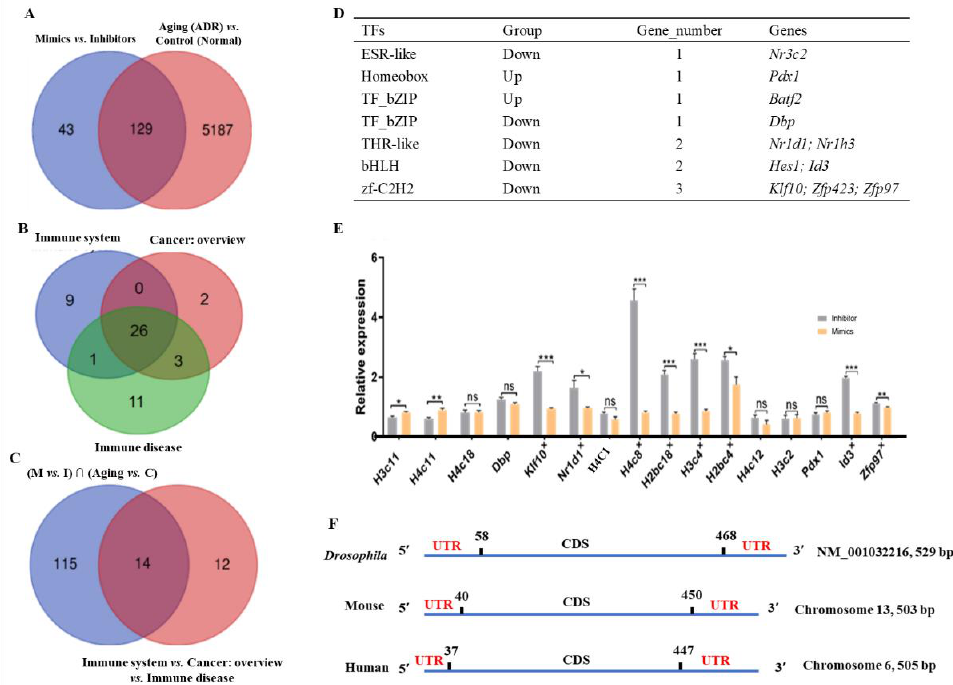
Figure 7. Target screening of tRF-Trp-CCA-014 in mouse NIH3T3 cells. ( A ) the overlapping DEGs between Mimics vs. Inhibitors groups and Aging (adriamycin ageing (adriamycin (ADR)) vs. Control (Normal) groups; ( B ) the overlapping DEGs in the immune system, cancer: overview, and immune disease; ( C ) the overlapping DEGs in ( A , B ); ( D ) the differentially expressed transcription factors between the Mimics vs. Inhibitors groups, including two upregulated genes and nine downregulated genes in the Inhibitors group when compared with the Mimics group; ( E ) the relative expression level of DEGs by qPCR; ( F ) sequence alignment of the H3C4 gene in mouse, human, and Drosophila . In ( C ): M—mimics; I—inhibitors; Aging—with ADR treatment; C—control (without ADR